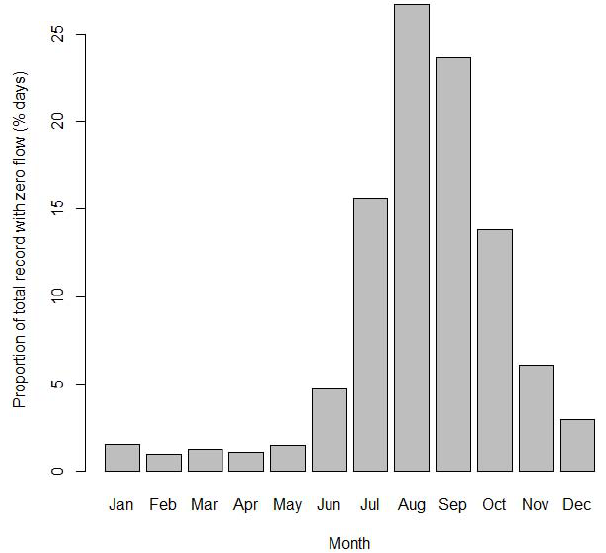
Fig. 3. Monthly variation in the occurrence of zero flow days. The days with zero flow in each month was computed from the flow records for all 123 intermittent